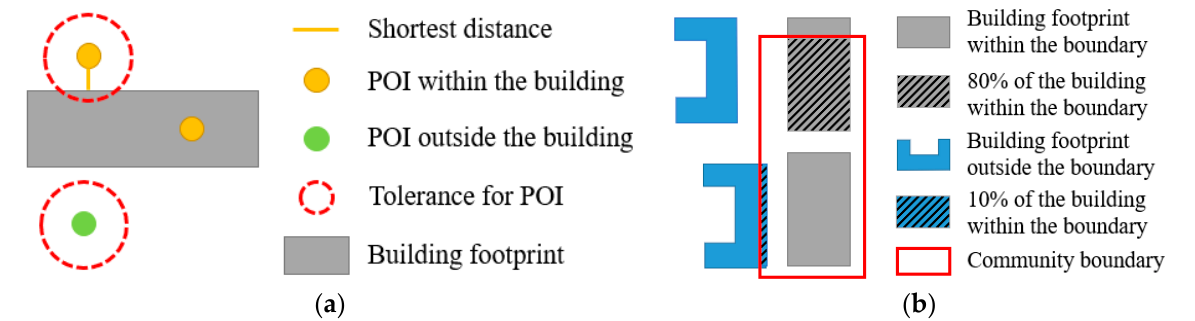
Figure 3. ( a ) Assign POI to the building footprint. ( b ) Assign community tag to the building footprint.